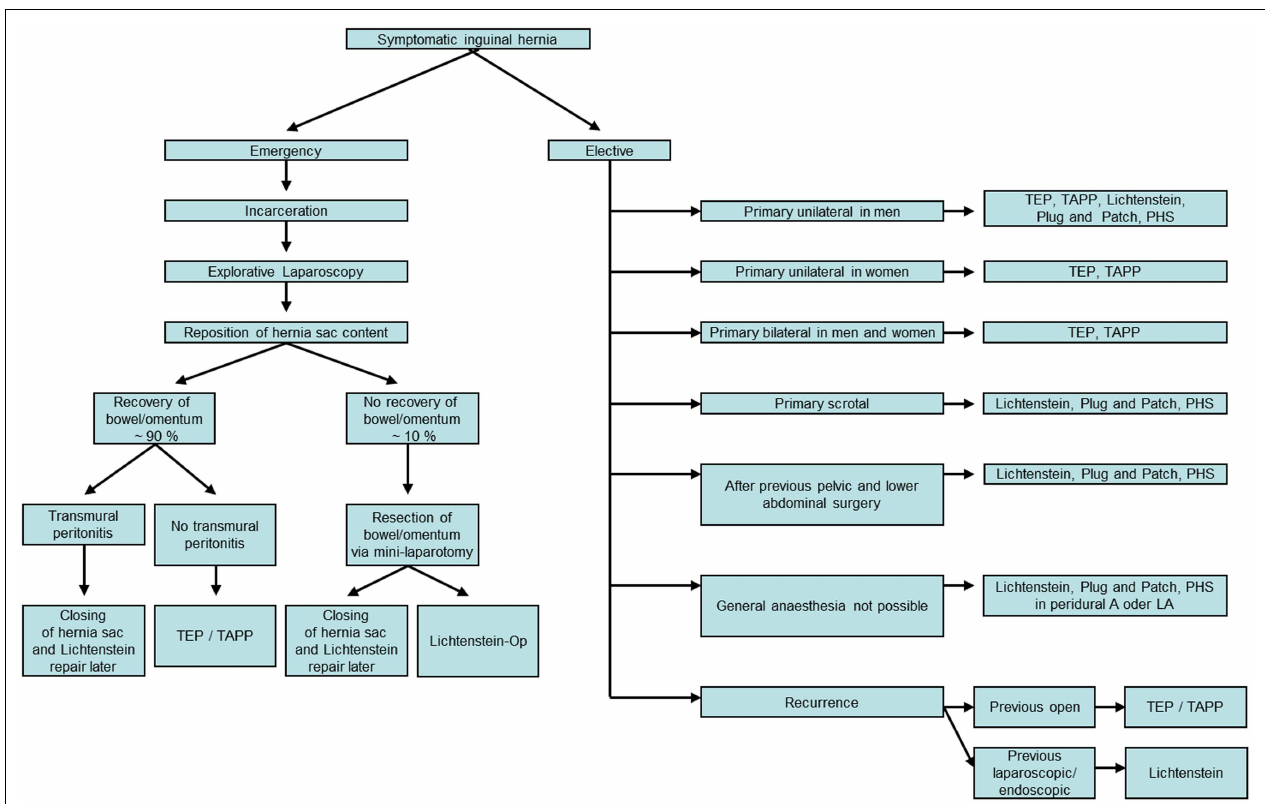
FIGURE 1 | Inguinal hernia repair based on the guidelines of the European Hernia Society, the International Endohernia Society, and the European Association of Endoscopic Surgery using the “tailored